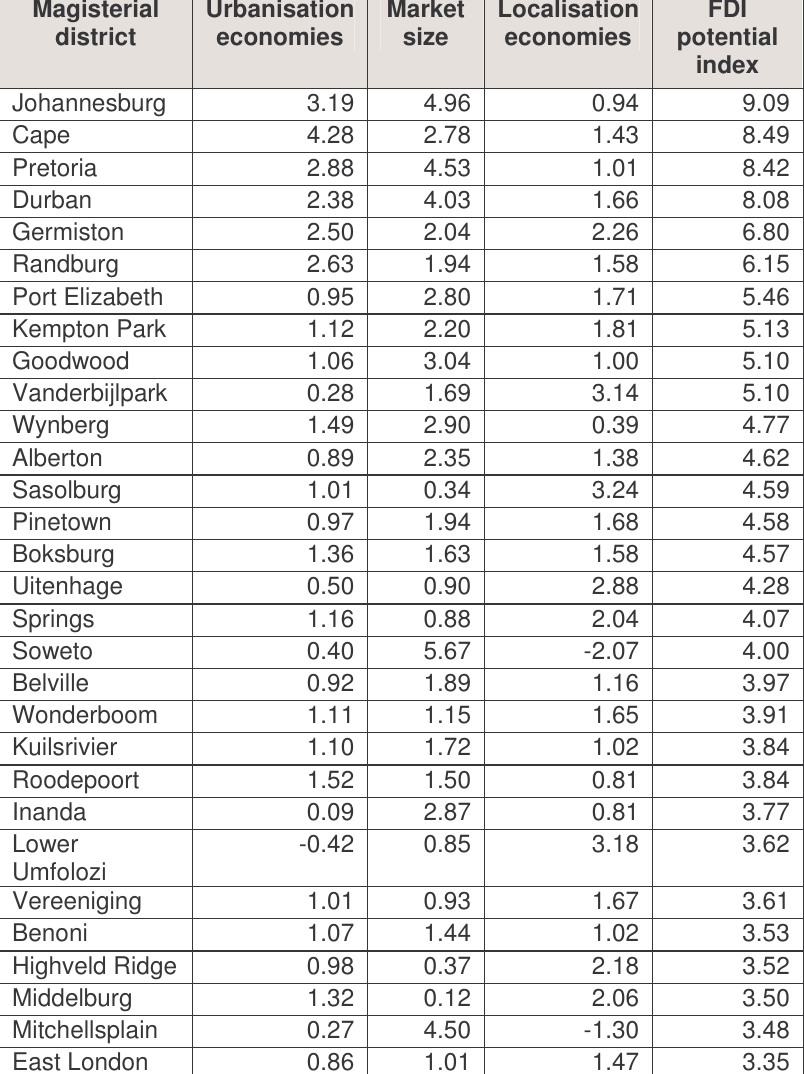
Table 6: FDI potential index ranking in